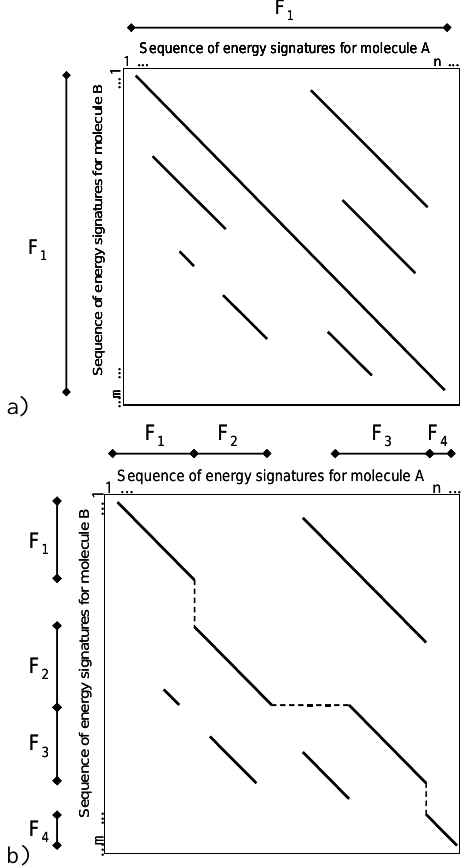
Fig. 9. Similarity matrix with the best alignment path traced through it: a) alignment of consecutive residues, b) alignment with